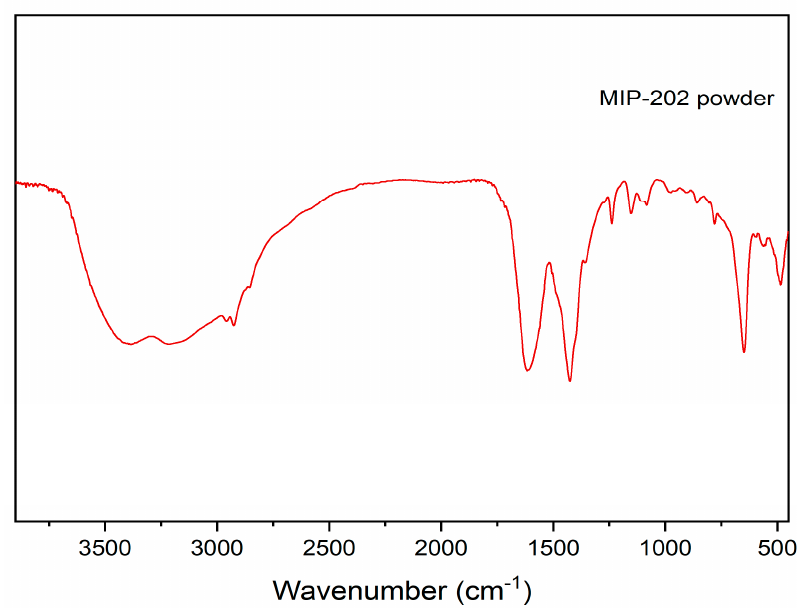
Figure 2. FTIR spectra of prepared Bio-MOF (MIP-202).